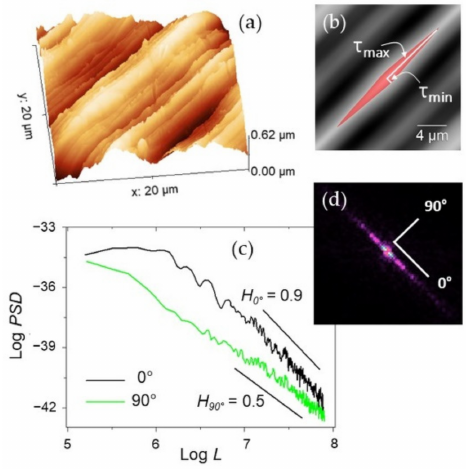
Figure 2. ( a ) Representative 20 × 20 µ m 2 AFM image of Ti-6Al-4V and ( b ) its autocorrelation image with indication of the central lobe (red area) and of the corresponding minimum and maximum lag τ min and τ max . ( c ) A Log-Log plot of the PSD functions calculated over the same image along the lay (0 ◦ direction, black curve) and across it (90 ◦ , green curve) with indication of the different slopes obtained along the corresponding directions. ( d ) FFT of the image in ( a